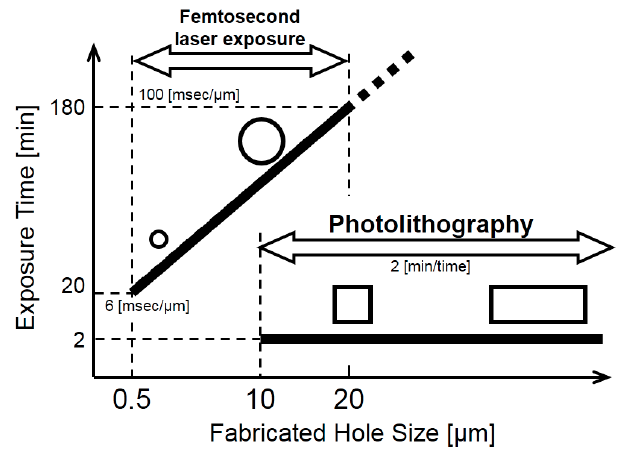
Figure 13. Schematic drawing of cross-sections of microchannels fabricated using femtosecond laser exposure and classical photolithography.